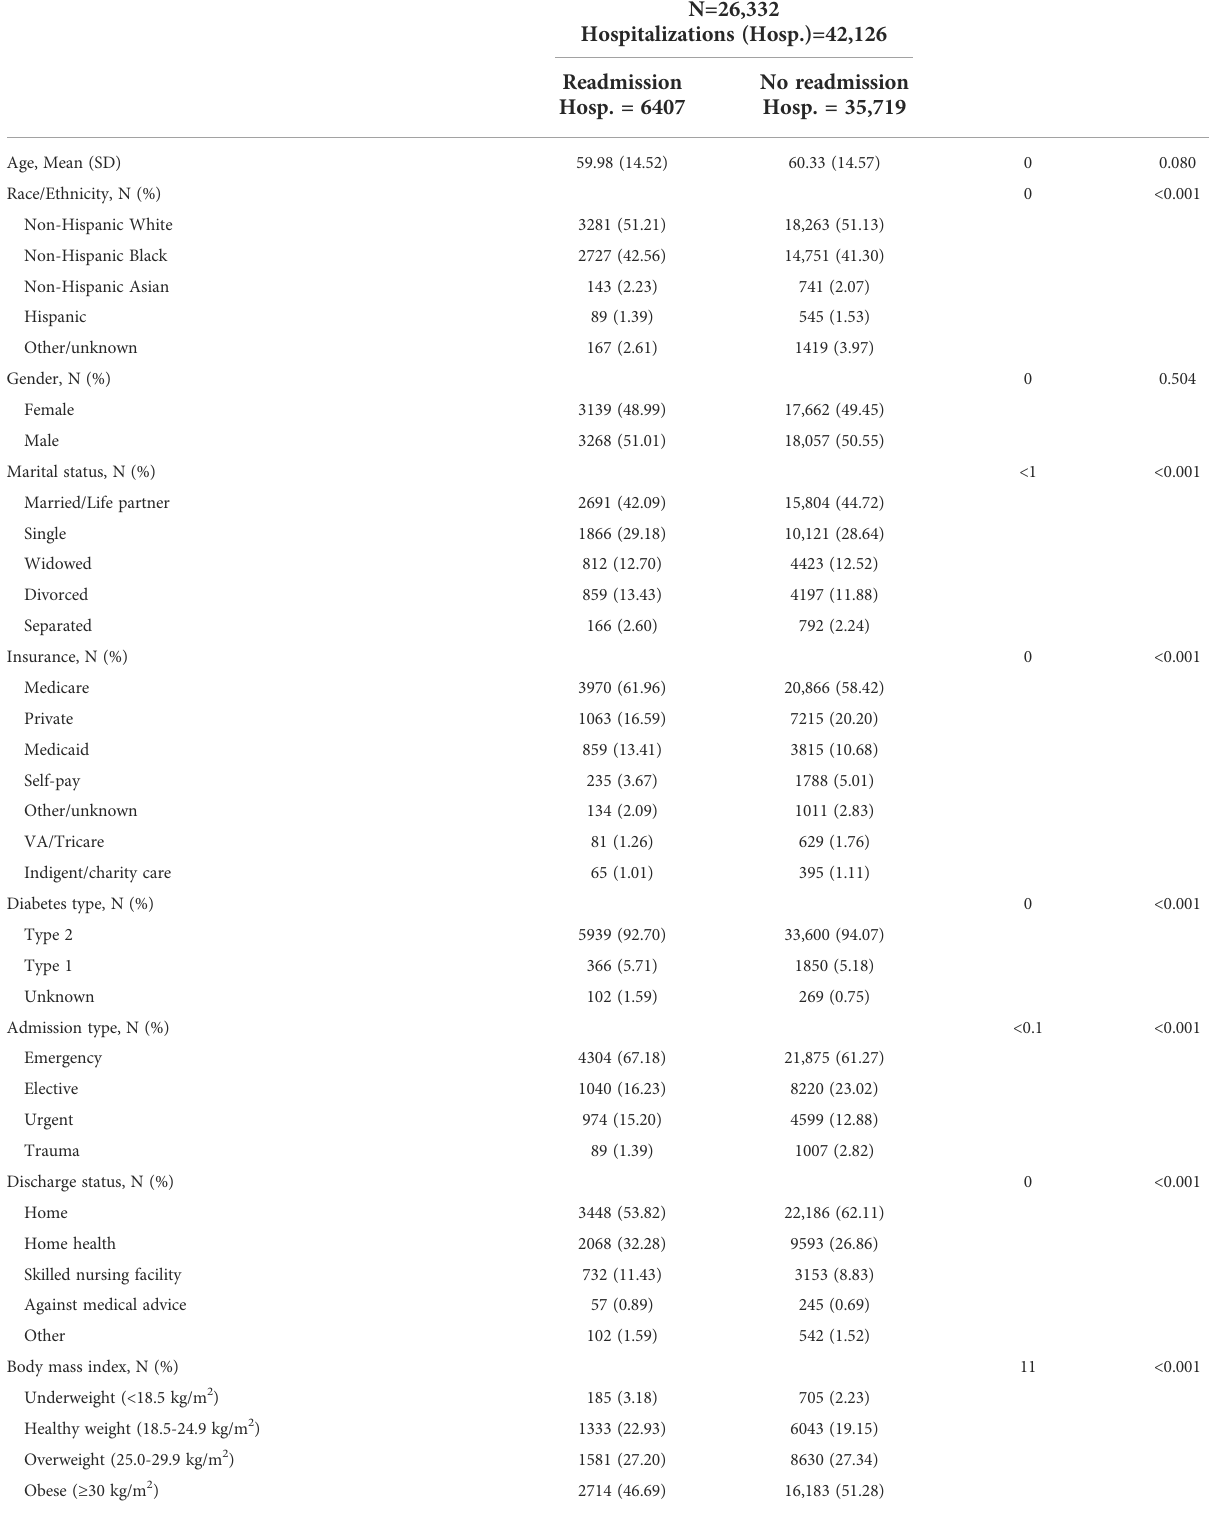
TABLE 1 Demographic characteristics and risk factors of index